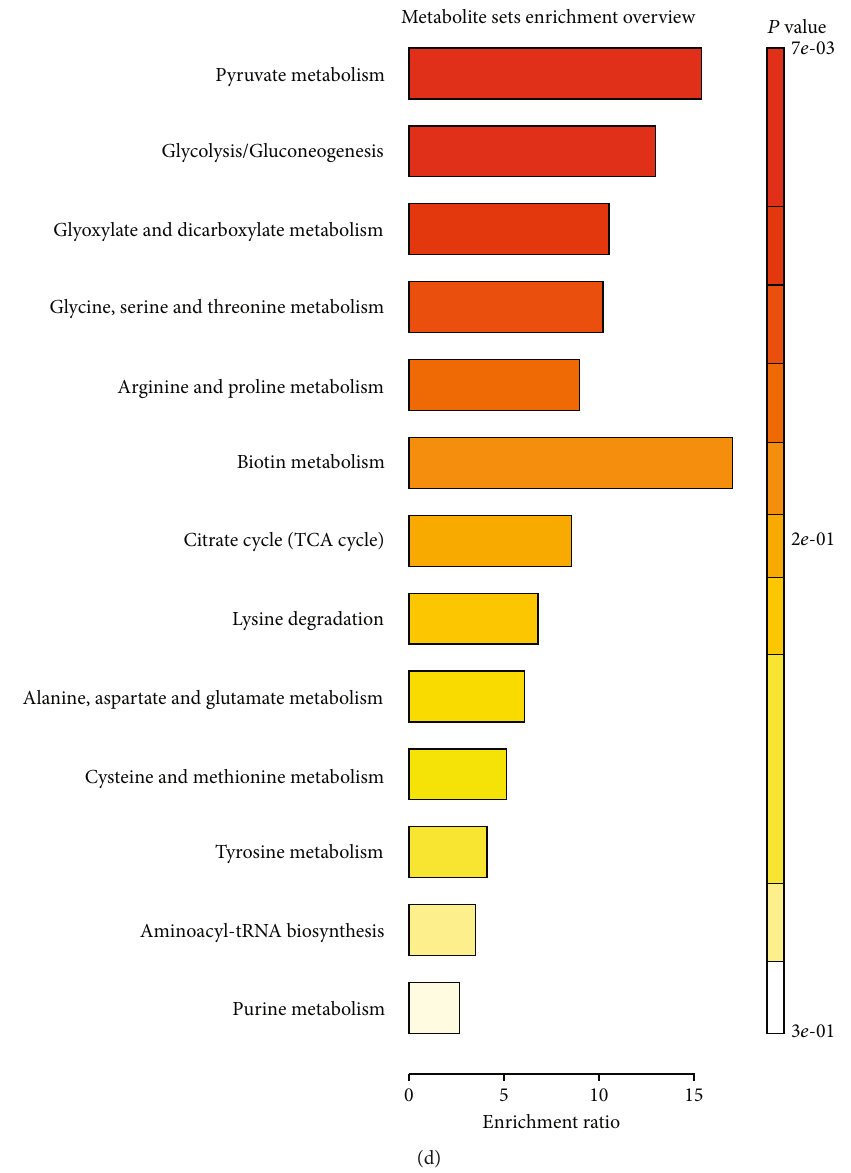
Figure 6: Metabolomics analysis of gastrocnemius tissue in tumor-bearing mice after curcumin intervention. (a) PLS-DA scatter plot of gastrocnemius samples in the model group and the curcumin group ( n = 8 /group). (b) Validation plot of gastrocnemius samples obtained from the model and curcumin groups ( n = 8 /group). (c) Gastrocnemius di ff erential metabolites fi ltered by the conditions of VIP > 1 and p < 0 : 05 . (d) Pathway analysis of di ff erential metabolites; ∗∗ p < 0 : 01 by t -test, compared to the model group. Data were shown as mean ± standard errorsof themean